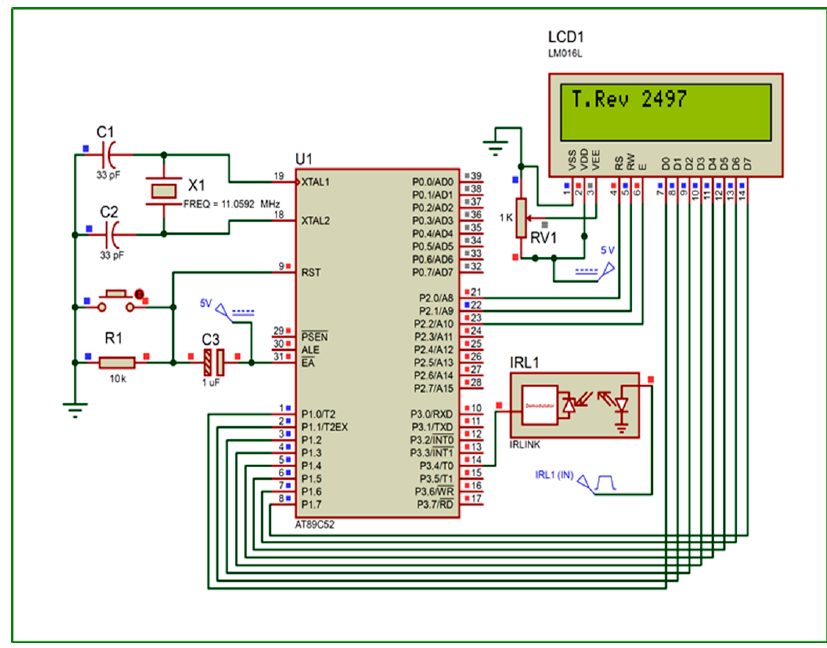
Figure 4. Schematic diagram of the signal counter circuit and display of the signal numbers in the Liquid crystal display (LCD).